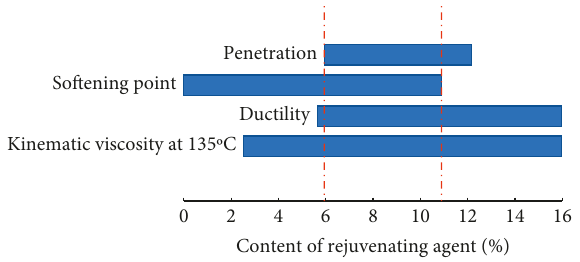
Figure 9: Optimum content of rejuvenating agent (first level).